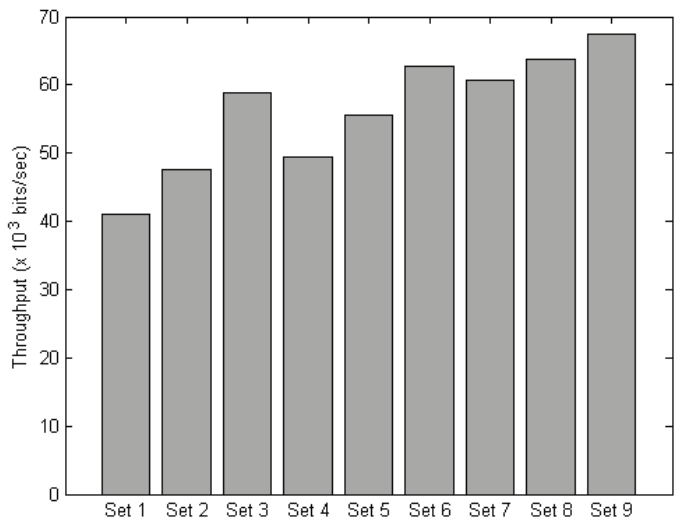
Figure 14. Throughput of the protocol